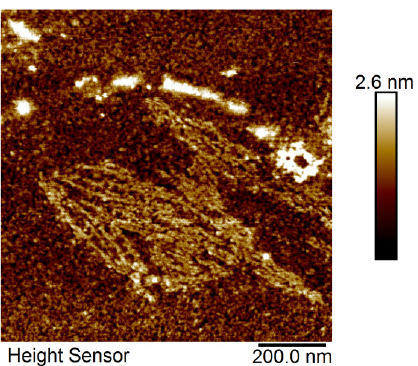
Figure 3. AFM microscopy of HEWL oligomer intermediates.